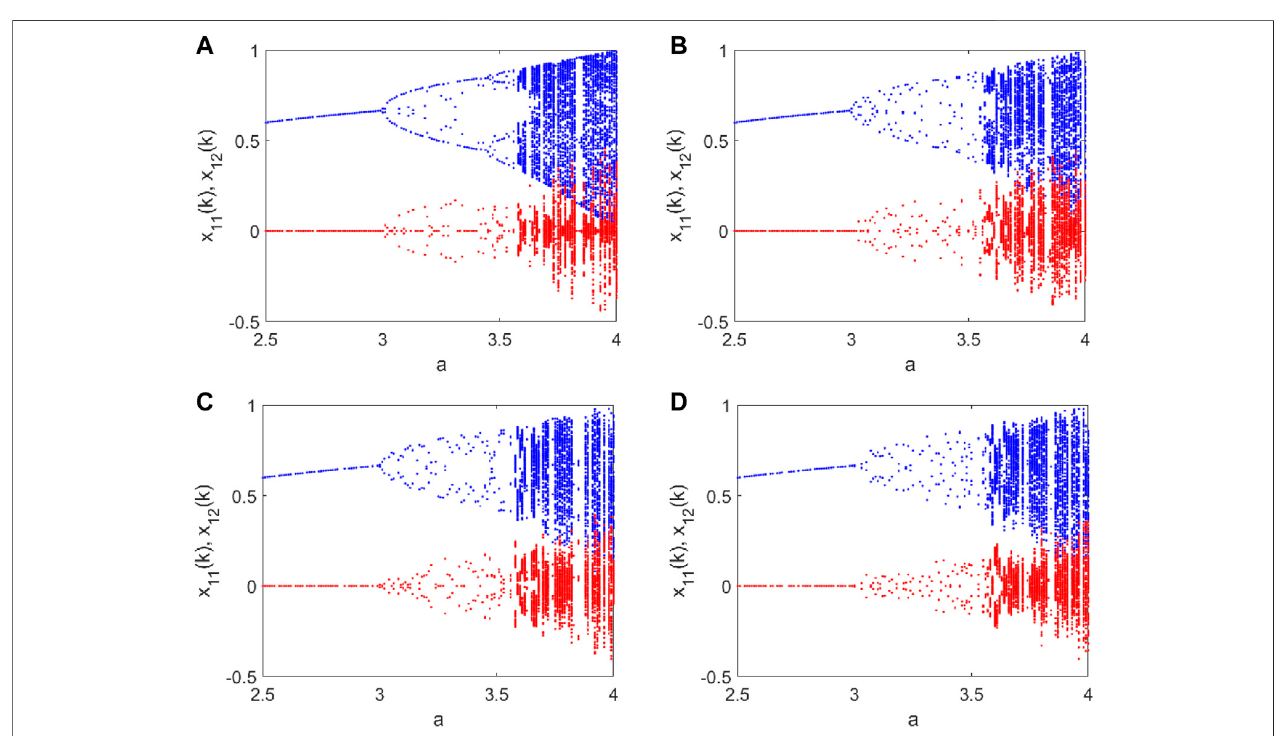
FIGURE 4 | Bifurcation diagram of the multidimensional logistic map in Eq. 16 with respect to a : (A) N = 2; (B) N = 3; (C) N = 4; and (D) N = 5.